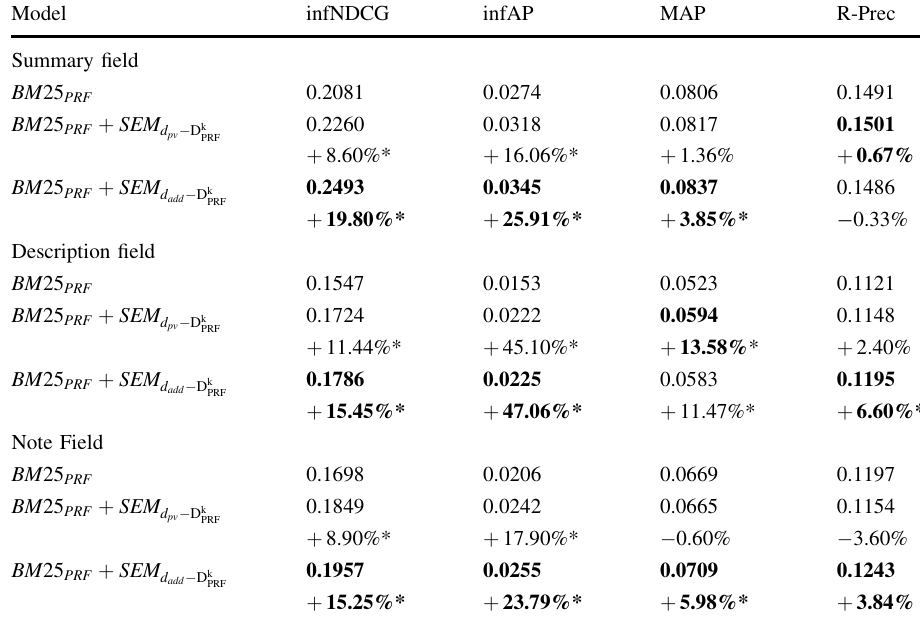
Table 5 Comparison between our approach and BM 25 þ Sim d [32] on the TREC Para (cid:3) Q 2014 and 2015 CDS task